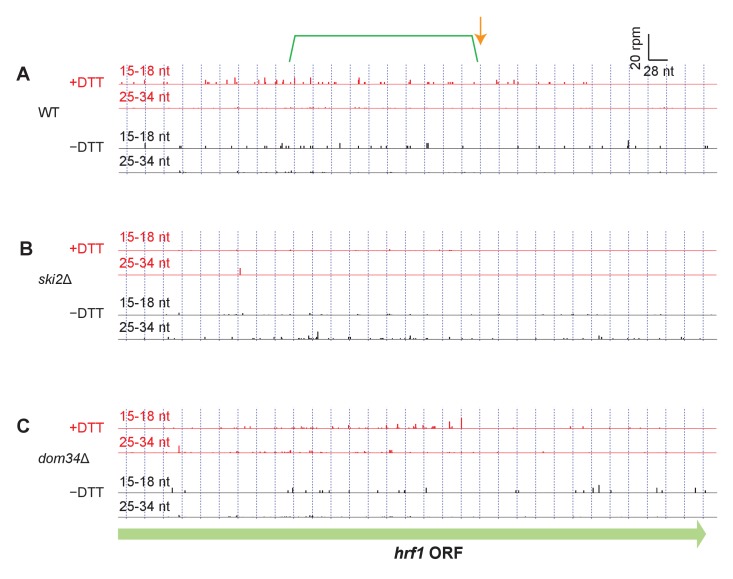
Read alignment to an example gene in different strain backgrounds. (A–C) Same as Figure 3C but showing additional datasets for hrf1. For reference, annotation of the original stall site and upstream NGD cleavage in Figure 3B have been retained.